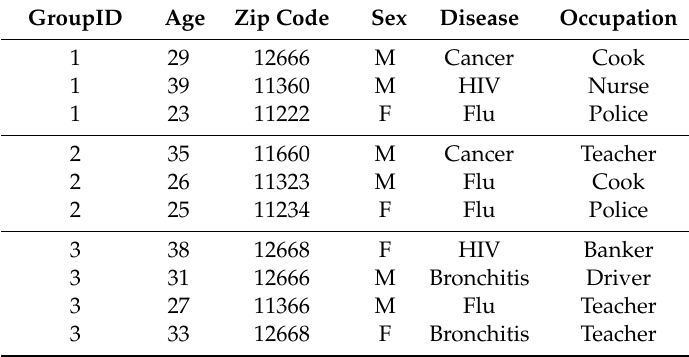
Table 8. Result of sensitive attributes